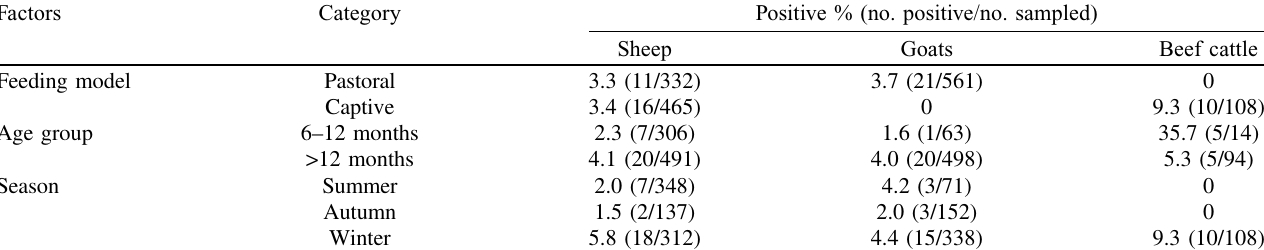
Table 2. Prevalence of G. duodenalis under different conditions.